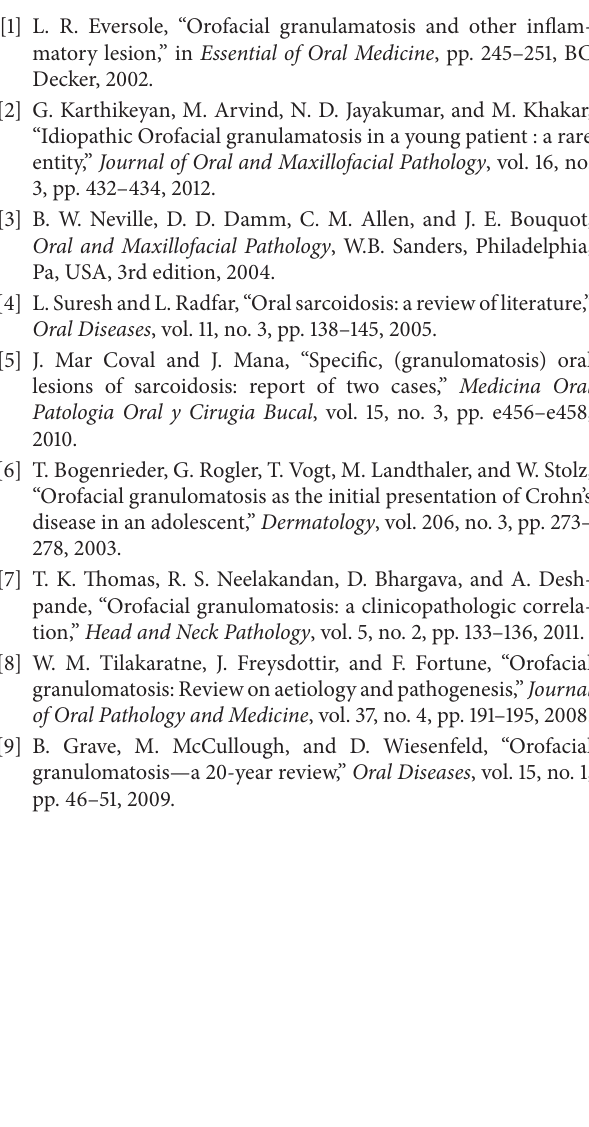
Table 2: Differential diagnosis of orofacial